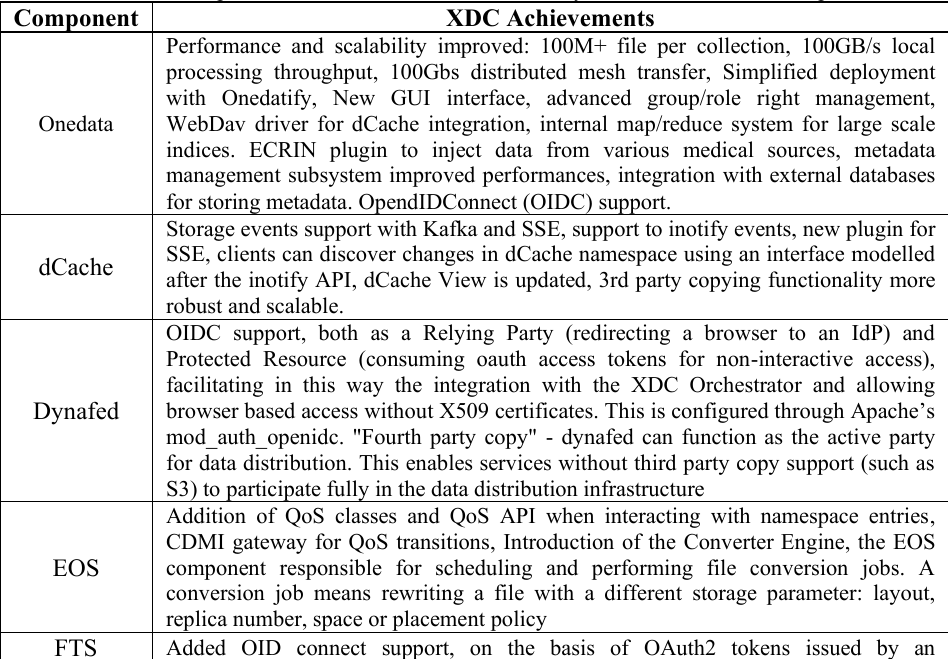
Table 3 - Main developments and new functionalities added by XDC to the released